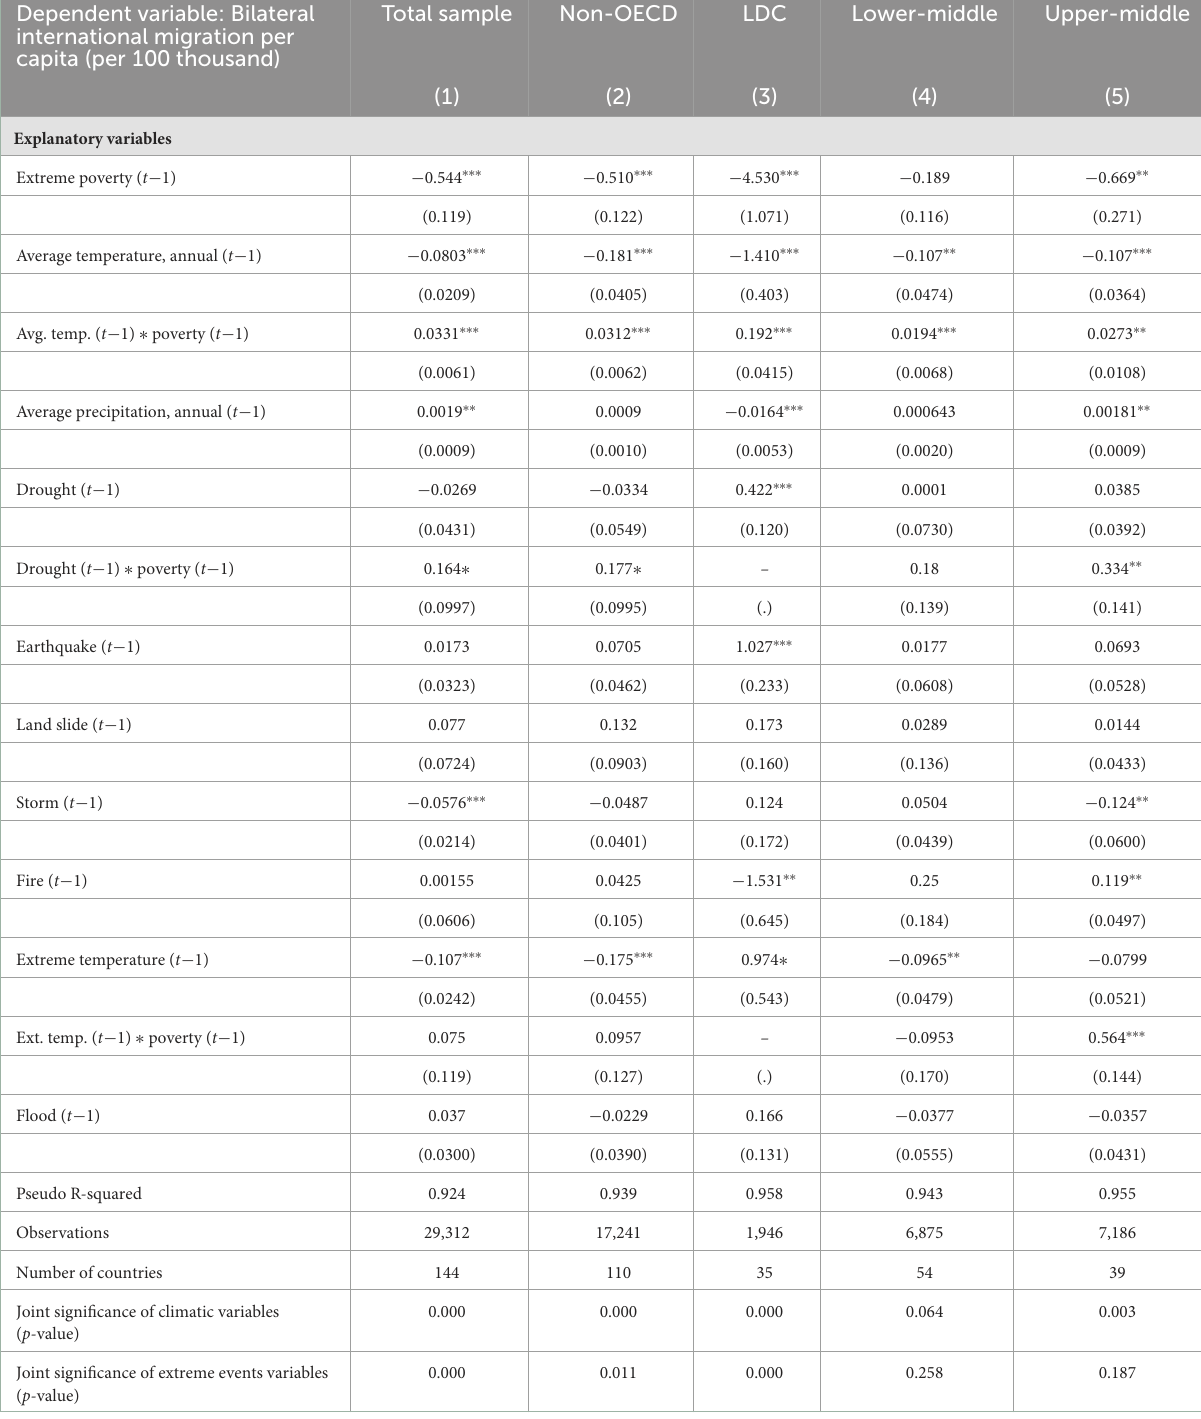
TABLE 3 The impact of climatic events on out-migration by economic sub-samples, including extreme poverty. Dependent variable: Bilateral international migration per capita (per 100